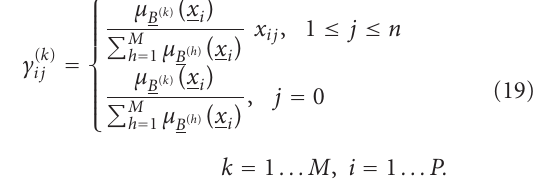
Figure 8: Initialization of hyperplane clustering for M = 4. Patterns belonging to the new generated clusters are represented by the symbols “x” and “o”, respectively; the first estimate of hyperplanes based on these subsets is shown by the continuous gray lines. Patterns represented by simple dots belong to the clusters associated with the hyperplanes that have not been split (dashed lines).